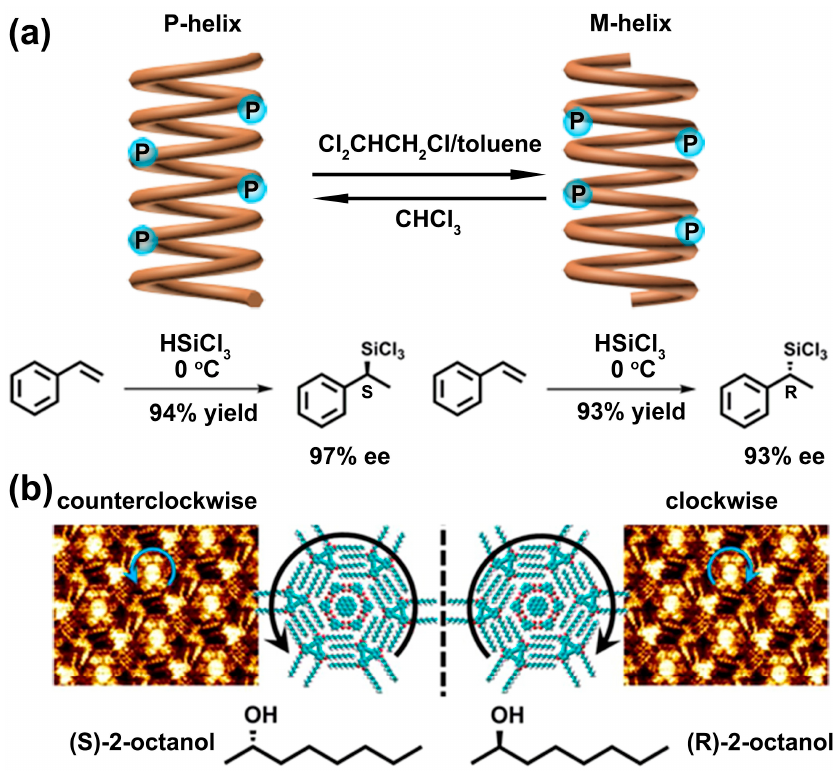
Figure 2. ( a ) Asymmetric hydrosilylation of styrenes using a PQXphos variant as ligand. Switching of enantioinduction in this reaction can be achieved by tuning the helix of the ligand via solvent stimuli; ( b ) DBA-OC10 can self-assemble into well-organized counterclockwise or clockwise nanopatterns at the (S)-2-octanol/highly oriented pyrolytic graphite (HOPG, left) and ( R )-2-octanol/HOPG interface (right), respectively, observed by high resolution-scanning tunneling microscope (HR-STM).